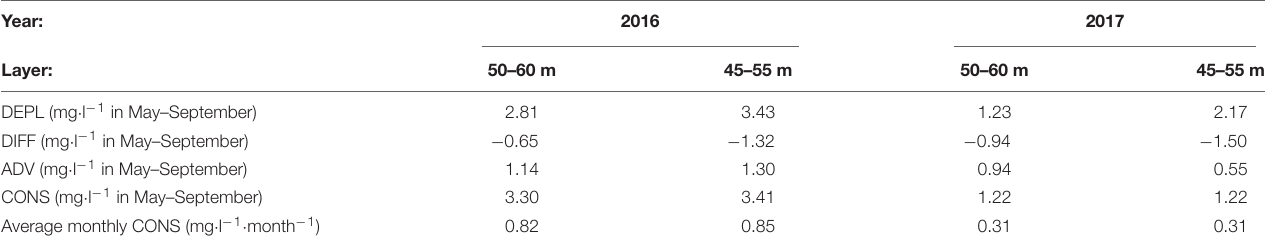
FIGURE 10 | Monthly average values of depletion (DEPL), diffusion (DIFF), advection (ADV), and consumption (CONS) in 2016 (A) and 2017 (B) . TABLE 3 | Average values of depletion (DEPL), diffusion (DIFF), advection (ADV), and consumption